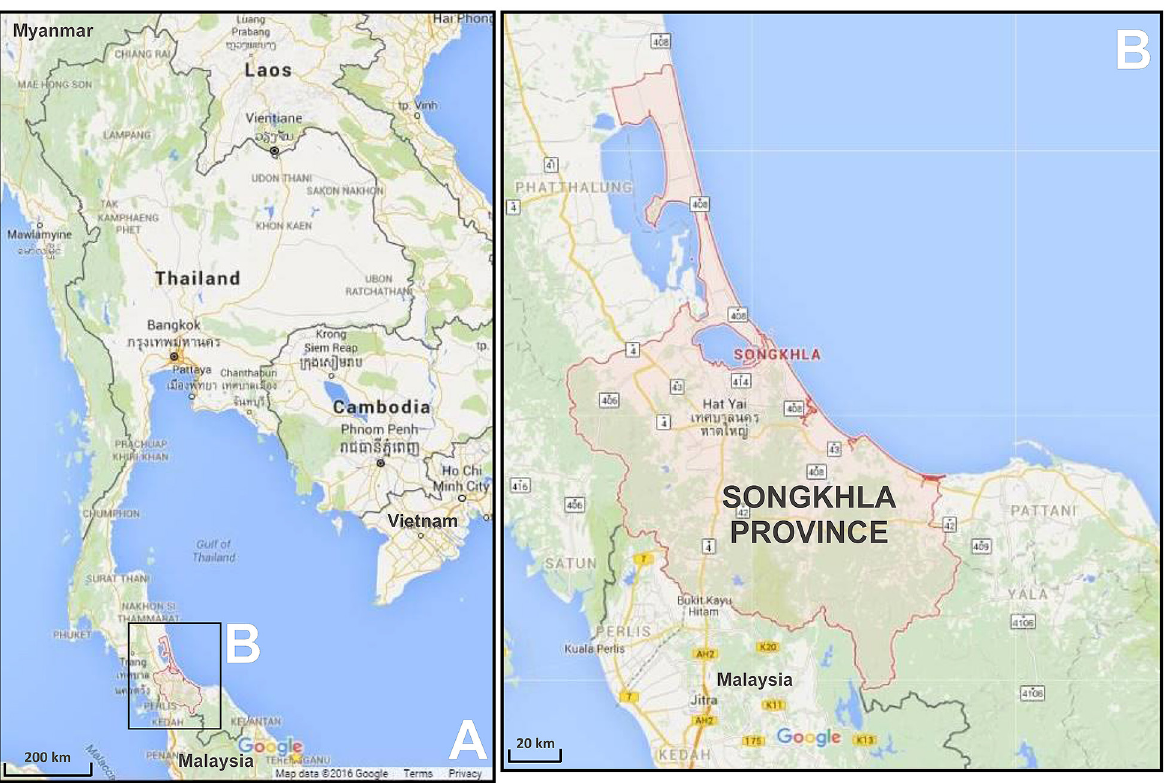
Fig. 1. Location map of the study area (source: Google Map, 2016). A – map of Thailand, B – map of Songkhla